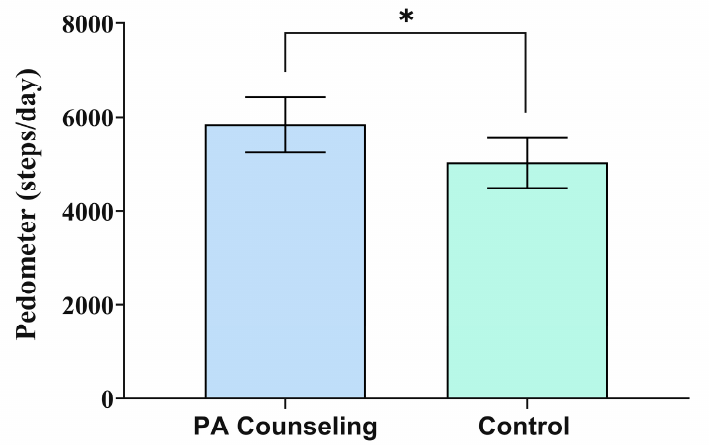
Figure 3. Pedometer-measured physical activity level of the participants from the physical activity (PA) counseling program group and control group at baseline and after 12 weeks. Data are expressed as estimated marginal means and 95% confidence interval. * Difference from the control group ( p = 0.044) through the generalized linear model with linear distribution model adjusted by baseline value.